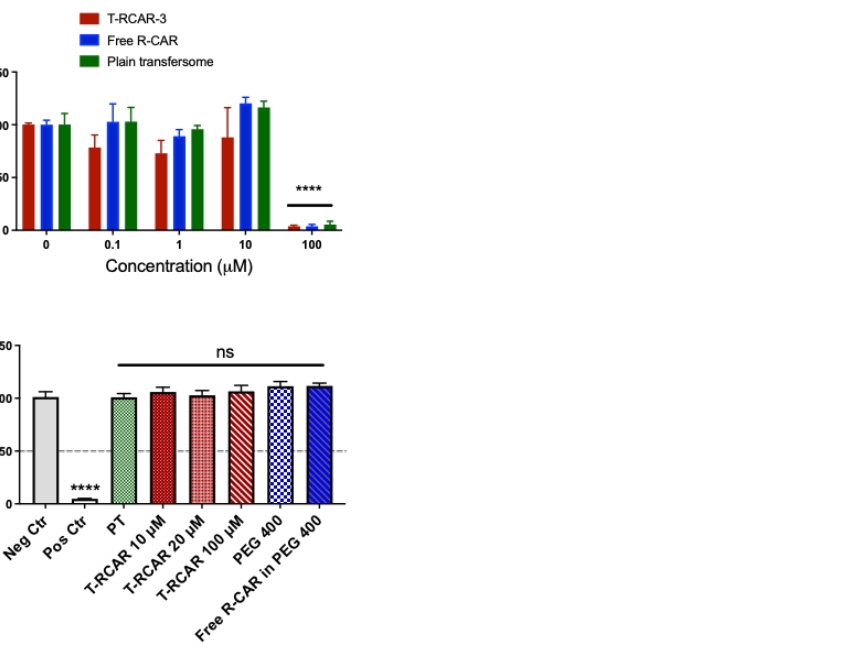
Figure 5. In vitro irritation test. ( A ) The 2D skin irritation test on JB6 cell culture. The cells were cultured in 96-well plates and treated with T-RCAR-3, free drug or PT for 48 h. MTT assay was used to evaluate the cell viability. The data were normalized by controls without treatment (n = 3). Only in treatment at the highest concentrations was there a statistically significant reduction in cell viability (ANOVA). ****: p < 0.0001. ( B ) The 3D skin irritation test on EpiDerm. MTT assay was conducted on EPI-200 tissues after topical applications of negative control (sterile DPBS), positive control (strong irritant, 5% SDS) or test agents in various doses for 60 min. The data were normalized by negative controls (n = 3). Only the positive controls (5% SDS) showed statistically significant reduction in cell viability (ANOVA). ****: p < 0.0001. ns: not